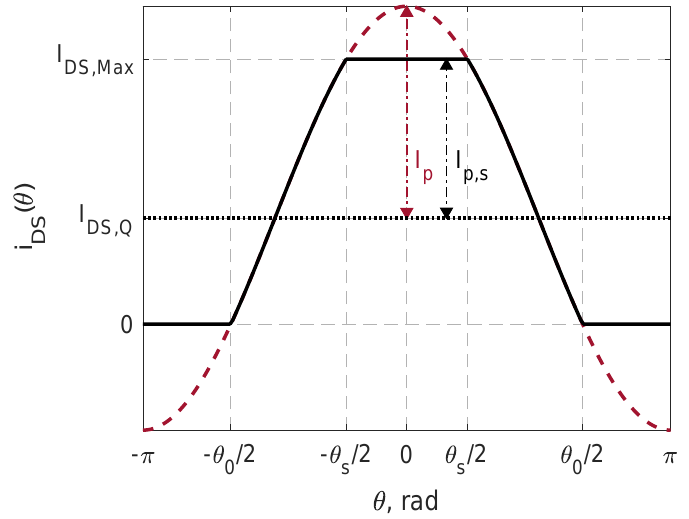
Figure 1. Clipped drain-source current